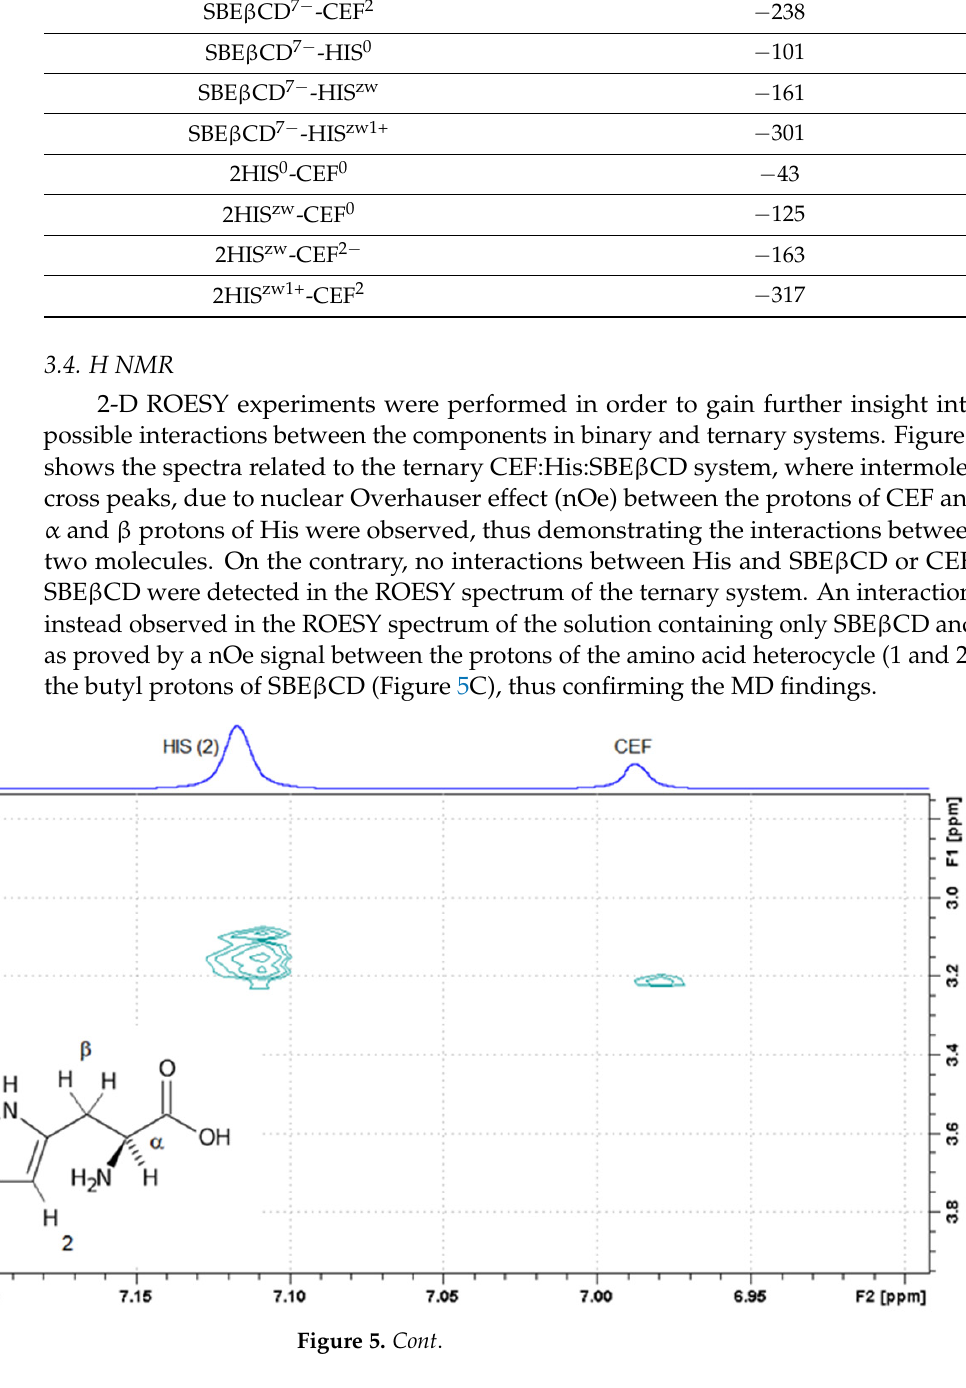
Table 2. Potential Energy gain (EP gain ) of the different binary systems CEF:SBE β CD and CEF:His calculated by MD simulation. Complex EP gain (KJ/mol) SBE β CD 7 − -CEF 0